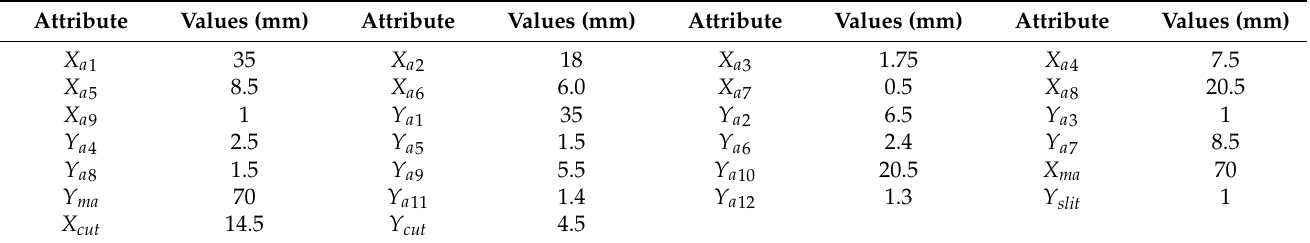
Figure 1. Schematic: ( a ) Antenna element; ( b ) MIMO antenna; ( c ) Top side of the antenna prototype; ( d ) Back side of the antenna prototype. Table 1. Geometrical attributes of the presented